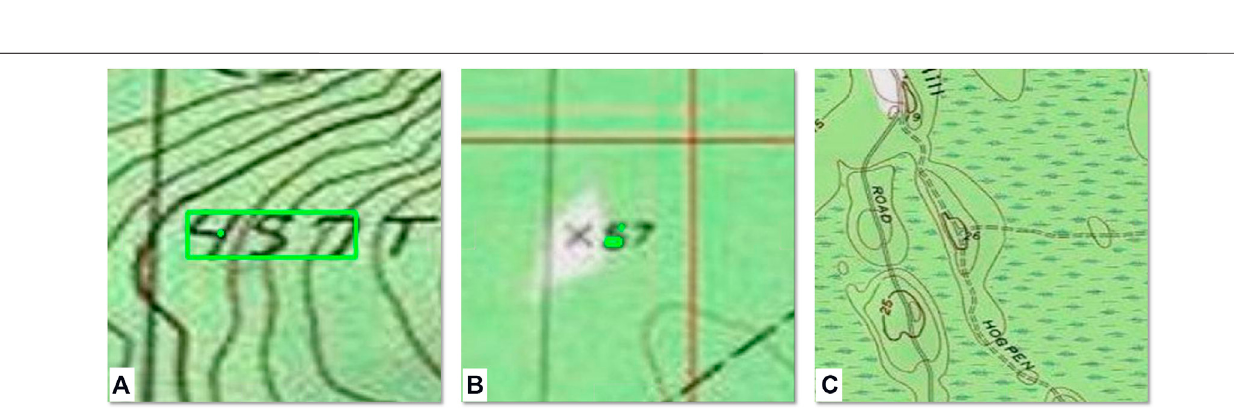
Frontiers in Environmental Science |